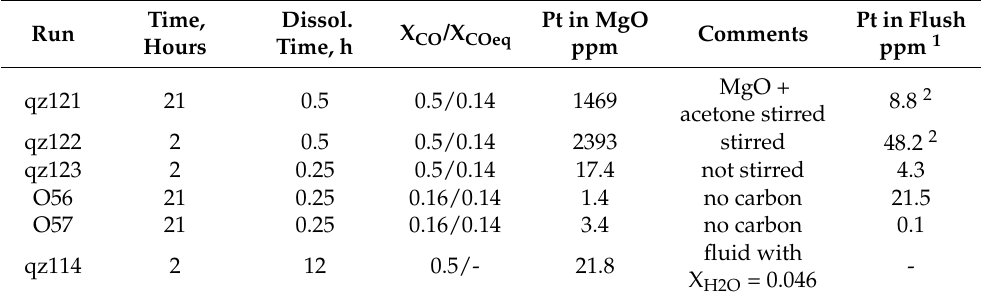
Figure 5. Interpretation of the experimental data on the Pt solubility in CO-CO 2 fluid at T = 950 °C. Circles are experimental points from Table 1. Curves plotted through the most reliable point P = 200 MPa and x CO = 0.14 (equilibrium CCO) are results of extrapolation for different formula of carbonyl complex Pt m (CO) n : n = 2; 3; 4; 5.5. Points beyond curves at P = 200 MPa are for different CO concentrations. Upper group (x CO = 0.19) short lines are calculated at n = 3 and 4.0 (best fit) and for the lower point (x CO = 0.09) at n = 3 and 4.5 (best fit). Point at P = 300 MPa is out of sequence. Table 2. Content of acetone-soluble Pt form in fluid traps and in washes from capsule